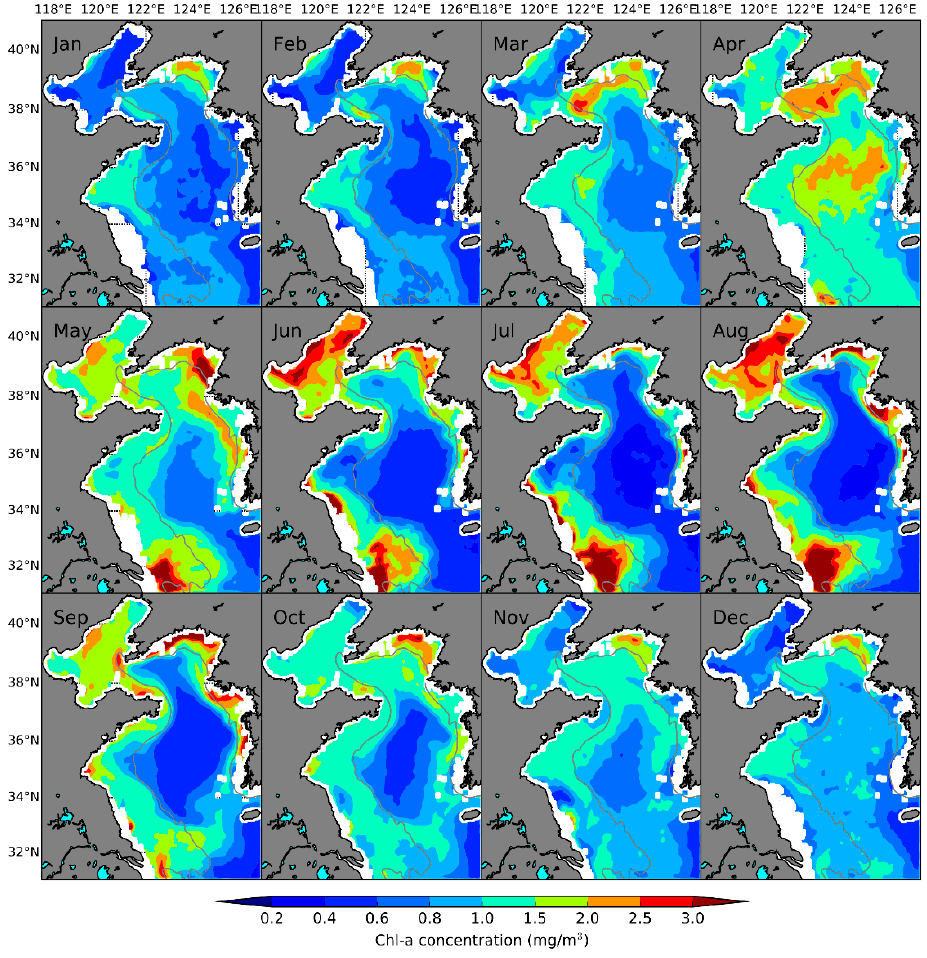
Figure 2. Monthly averaged chl-a concentration (mg/m 3 ). The gray lines denote the 40 m isobath. As indicated by [36], topography plays an important role in the seasonal pattern of chl-a in the YB sea, which is consistent with the results discussed above. Therefore, the chl-a in the YB sea was divided into three sections for seasonal variation analysis: the offshore zone (water depth ≥ 40 m), the Yellow Sea coastal zone (water depth < 40 m), and the Bohai Sea. The area of the Bohai Sea with a water depth of <40 m was isolated from the coastal zone due to the fact that it is an enclosed sea and has different hydrodynamic characteristics from those of the relatively open coastal zone along the Yellow Sea coastline. As illustrated in Figure 3, the chl-a concentrations in the offshore zone, the coastal zone, and the Bohai Sea exhibit a notable seasonal variation. In the offshore zone, chl-a exhibits two peaks in spring and autumn, respectively. The chl-a concentration is highest (~1.5 mg/m 3 ) in April due to the spring bloom in the Yellow Sea offshore zone; the other peak (~0.9 mg/m 3 ) in autumn is relatively lower than in spring. The lowest chl-a concentration (~0.5 mg/m 3 ) occurs in summer. The chl-a in the coastal zone exhibits a unimodal variation whereby chl-a is highest in the summer and lowest in the winter. The chl-a variation in the Bohai Sea is similar to that in the Yellow Sea coastal zone, albeit approximately 0.5 mg/m 3 higher in summer and 0.3 mg/m 3 lower in winter.